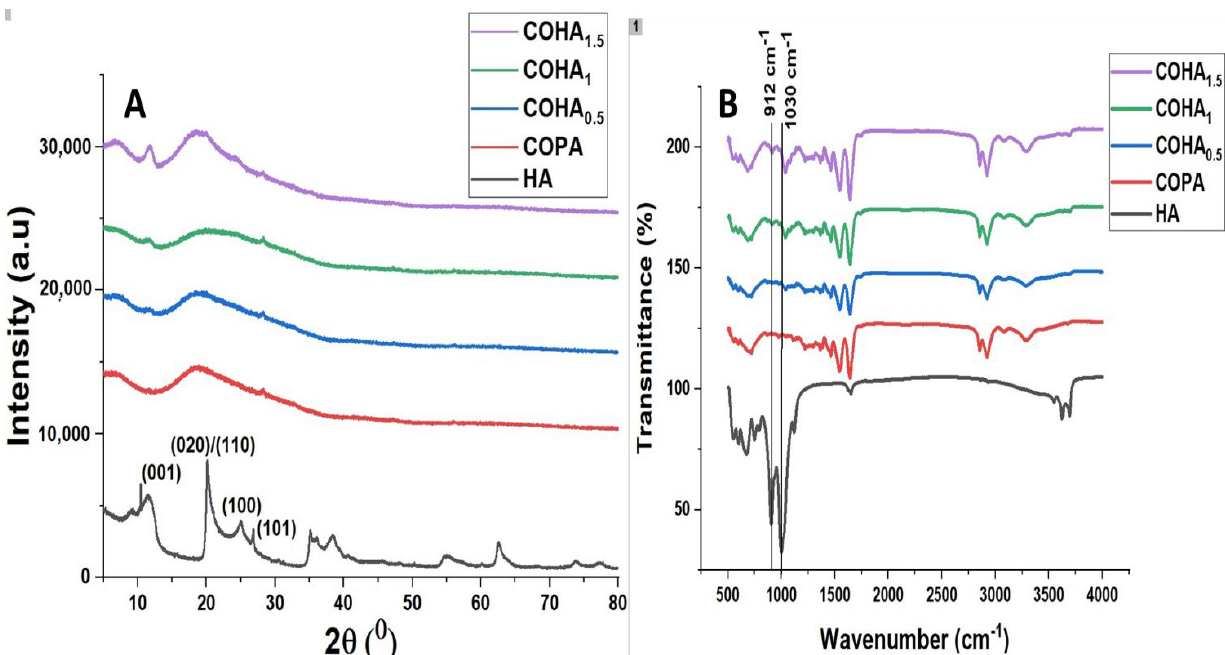
Figure 4. ( A ) FTIR spectra for copolyamide–halloysite composite nanofibers ( B ) XRD patterns for copolyamide–halloysite clay nanocomposite nanofibers.